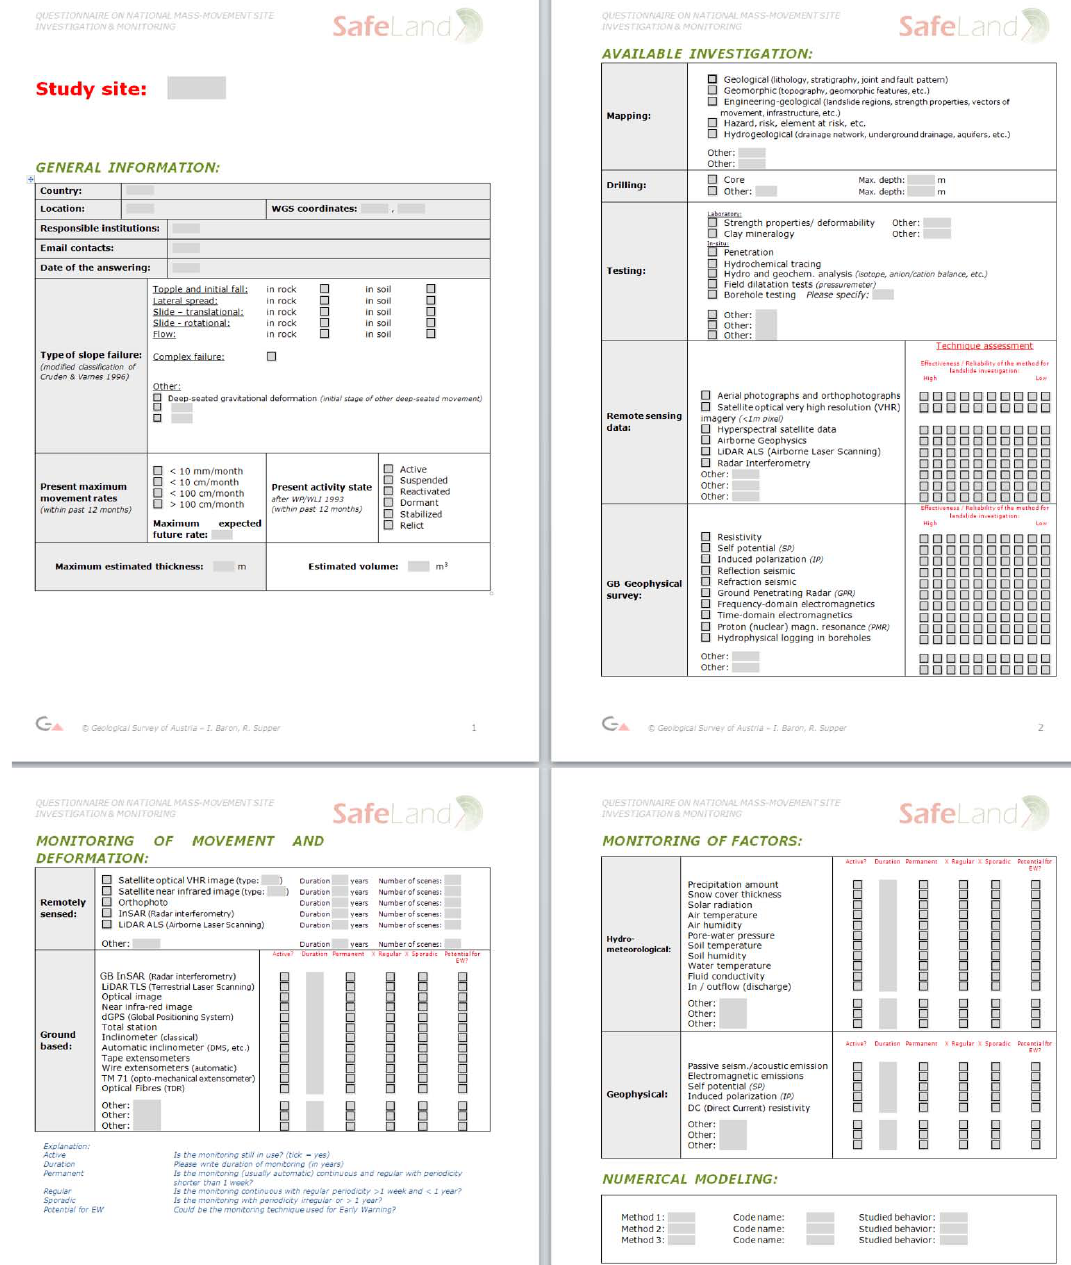
Fig. 1. General appearance of the “Questionnaire on National State of Landslide Site Investigation and